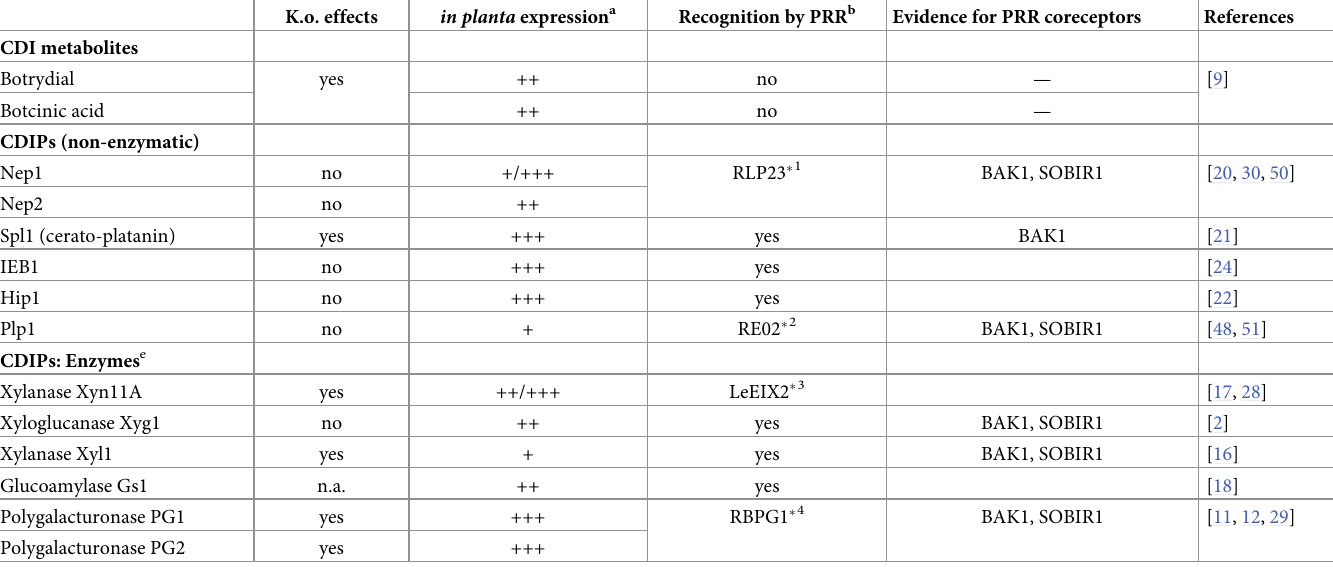
Table 1. Cell death-inducing metabolites and proteins of Botrytis cinerea